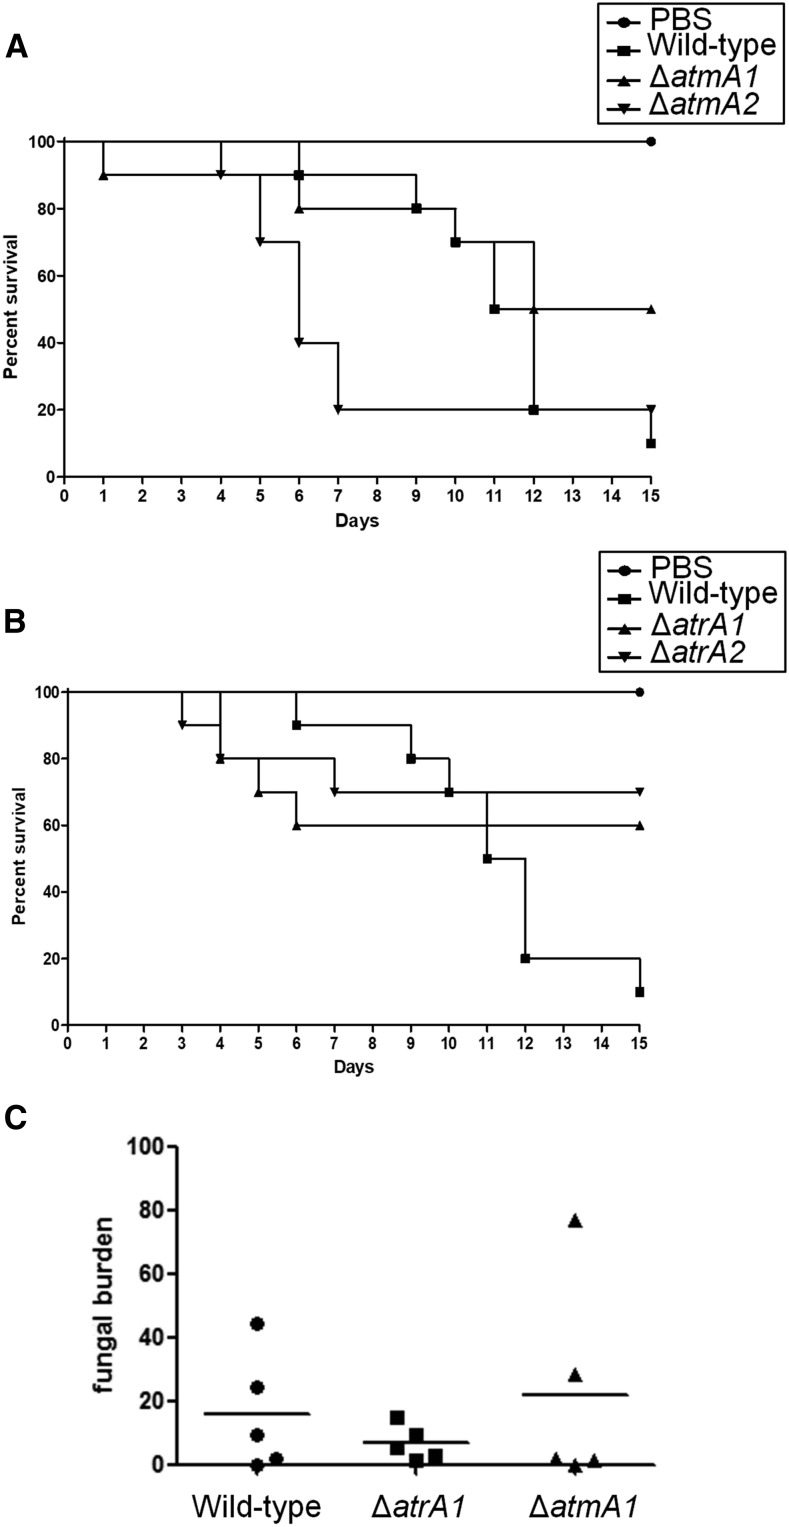
A. fumigatus ΔatmA and ΔatrA are still virulent. Comparative analysis of wild-type and mutant strains in a neutropenic murine model of pulmonary aspergillosis. Mice in groups of 10 per strain were infected intranasally with a 20 μl suspension of conidia at a dose of 105 conidia. (A) Percent survival of ΔatmA1 and ΔatmA2 mutants compared to the wild-type strain. (B) Percent survival of ΔatrA1 and ΔatrA2 mutants compared to the wild-type strain. (C) Fungal burden quantification, determined by quantitative polymerase chain reaction from lungs obtained 72 hr postinfection. Results are expressed based on quantification of the 18S rRNA gene of A. fumigatus divided by the quantification of an intronic region of the mouse GAPDH gene. PBS, phosphate-buffered saline.